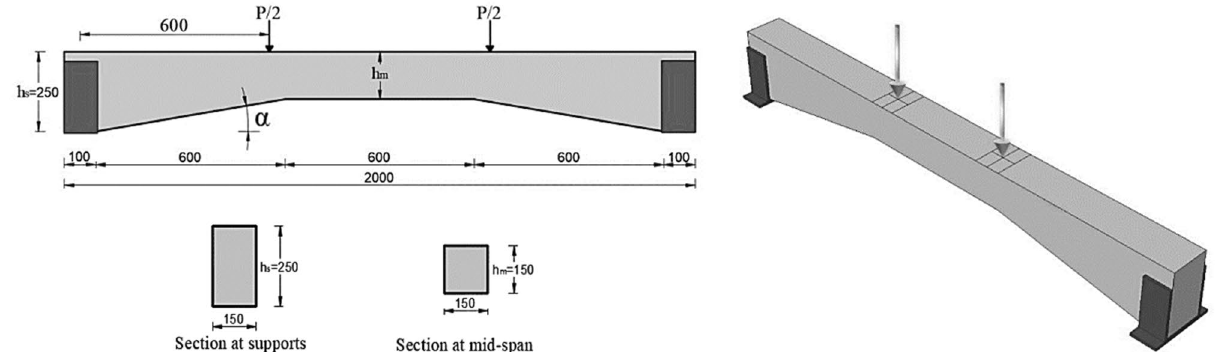
Figure 2. Geometry of the beams and the loading